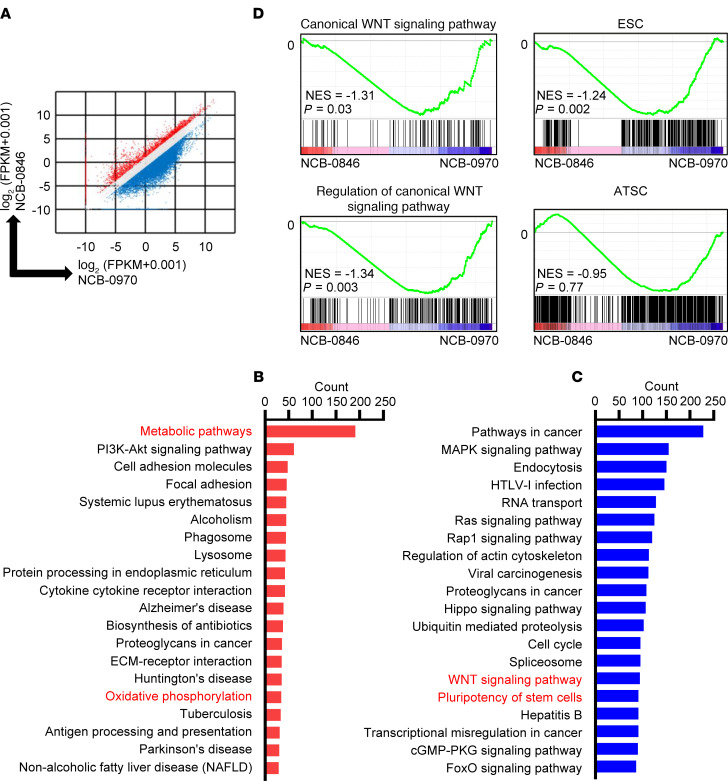
Transcriptome analysis of the effects of TNIK inhibitor in OS cells indicates upregulation of genes involved in metabolism and downregulation of genes involved in the Wnt signaling pathway and stem cell pluripotency.(A) Scatter plot analyses of differential gene expression in OS cells treated with NCB-0846 versus NCB-0970. U2OS cells were treated with 3 μM NCB-0846 or NCB-0970 for 24 hours. Each axis represents the log2 (FPKM + 0.001) value. Red dots indicate genes showing more than 2-fold upregulation, and blue dots indicate genes showing less than 0.5-fold downregulation. (B) Top 20 identified KEGG pathways from 3182 upregulated genes and (C) 11,920 downregulated genes. Counts of genes included in the pathways are depicted. (D) Gene set enrichment analysis (GSEA) showing significant enrichment of Wnt signaling–related genes (genes classified as being involved the canonical Wnt signaling pathway and its regulation) and an embryonic stem cell–related (ESC-related) gene set but not an adult tissue stem cell–related (ATSC-related) gene set, among genes downregulated by NCB-0846 (relative to NCB-0970) in U2OS cells. NES, normalized enrichment score.